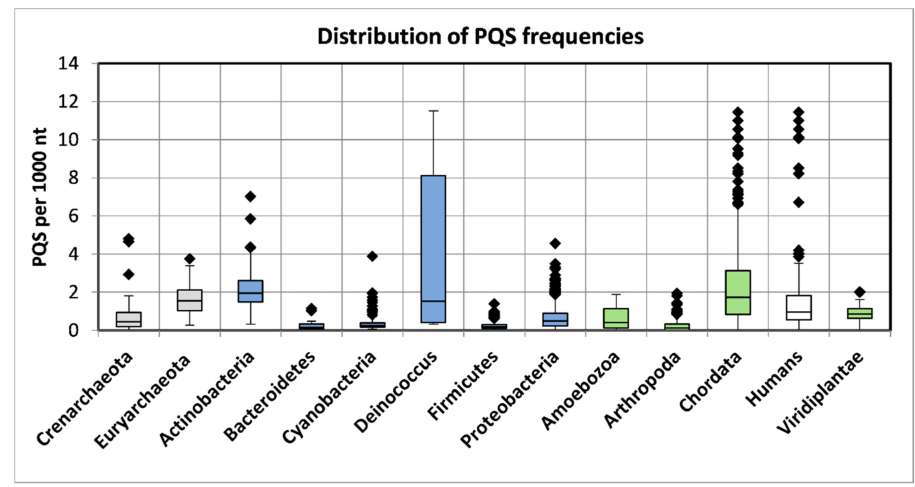
Figure 2. Frequencies of PQS in host groups of the analyzed viral genomes. Data within boxes span the interquartile range and whiskers show the lowest and highest values within the 1.5 interquartile range. Black diamonds denote outliers. The colors correspond to phylogenetic tree depiction.